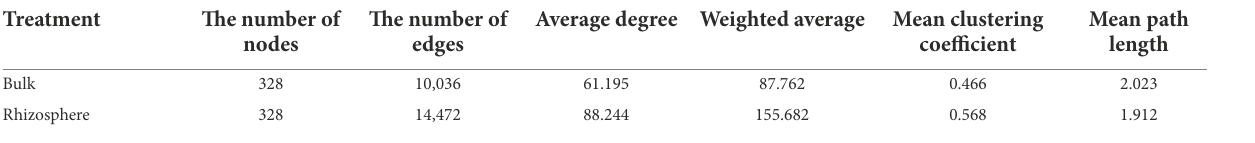
TABLE 1 Co-occurrence network analysis